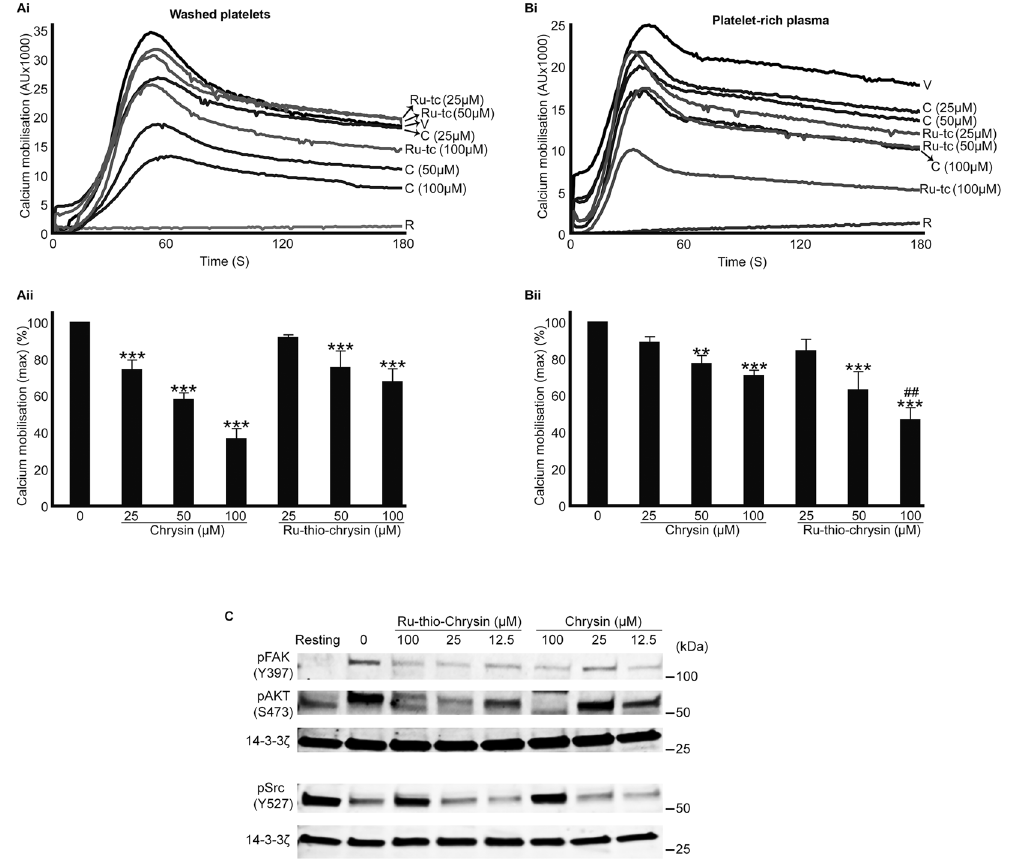
Figure 6. Chrysin and its derivatives influence the calcium mobilisation and phosphorylation of various signalling proteins in platelets. Fluo4 AM-dye labelled human washed platelets ( Ai , Aii ) and platelet-rich plasma ( Bi , Bii ) were treated with vehicle control (V) [0.1% (v/v) DMSO] or different concentrations of chrysin (C) or Ru-thio-chrysin (Ru-tc) for 5 minutes prior to the addition of 0.5 μ g/mL CRP-XL and monitoring of calcium mobilisation for three minutes by flourimetry. The calcium traces ( Ai and Bi ) shown are representative of three separate experiments. The maximum fluorescence obtained with each sample was converted into percentages to calculate the level of calcium mobilisation obtained with vehicle and chrysin or Ru-thio-chrysin treated samples. Cumulative data ( Aii and Bii ) represent mean ± S.D. (n = 3). * Indicates significance with respect to controls and # indicates significance with respect to the respective chrysin concentrations; p values shown ( ** ,## p < 0.01 and *** p < 0.001) are as calculated by one-way ANOVA using Graphpad Prism. ( C ) Human washed platelets were treated with vehicle control or different concentrations of chrysin or Ru-thio-chrysin for 5 minutes prior to the addition of 0.5 μ g/mL CRP-XL and incubation for another 5 minutes. The platelets were lysed and used for immunoblot analysis to detect the level of AKT phosphorylation at residue S473, FAK phosphorylation at Y397 and phosphorylation of Src at Y527. The level of 14-3-3 ζ protein was detected as a loading control. The cropped images of the blots shown here are representative of three separate experiments. The uncropped full length blots are presented in Supplementary Information (Figure